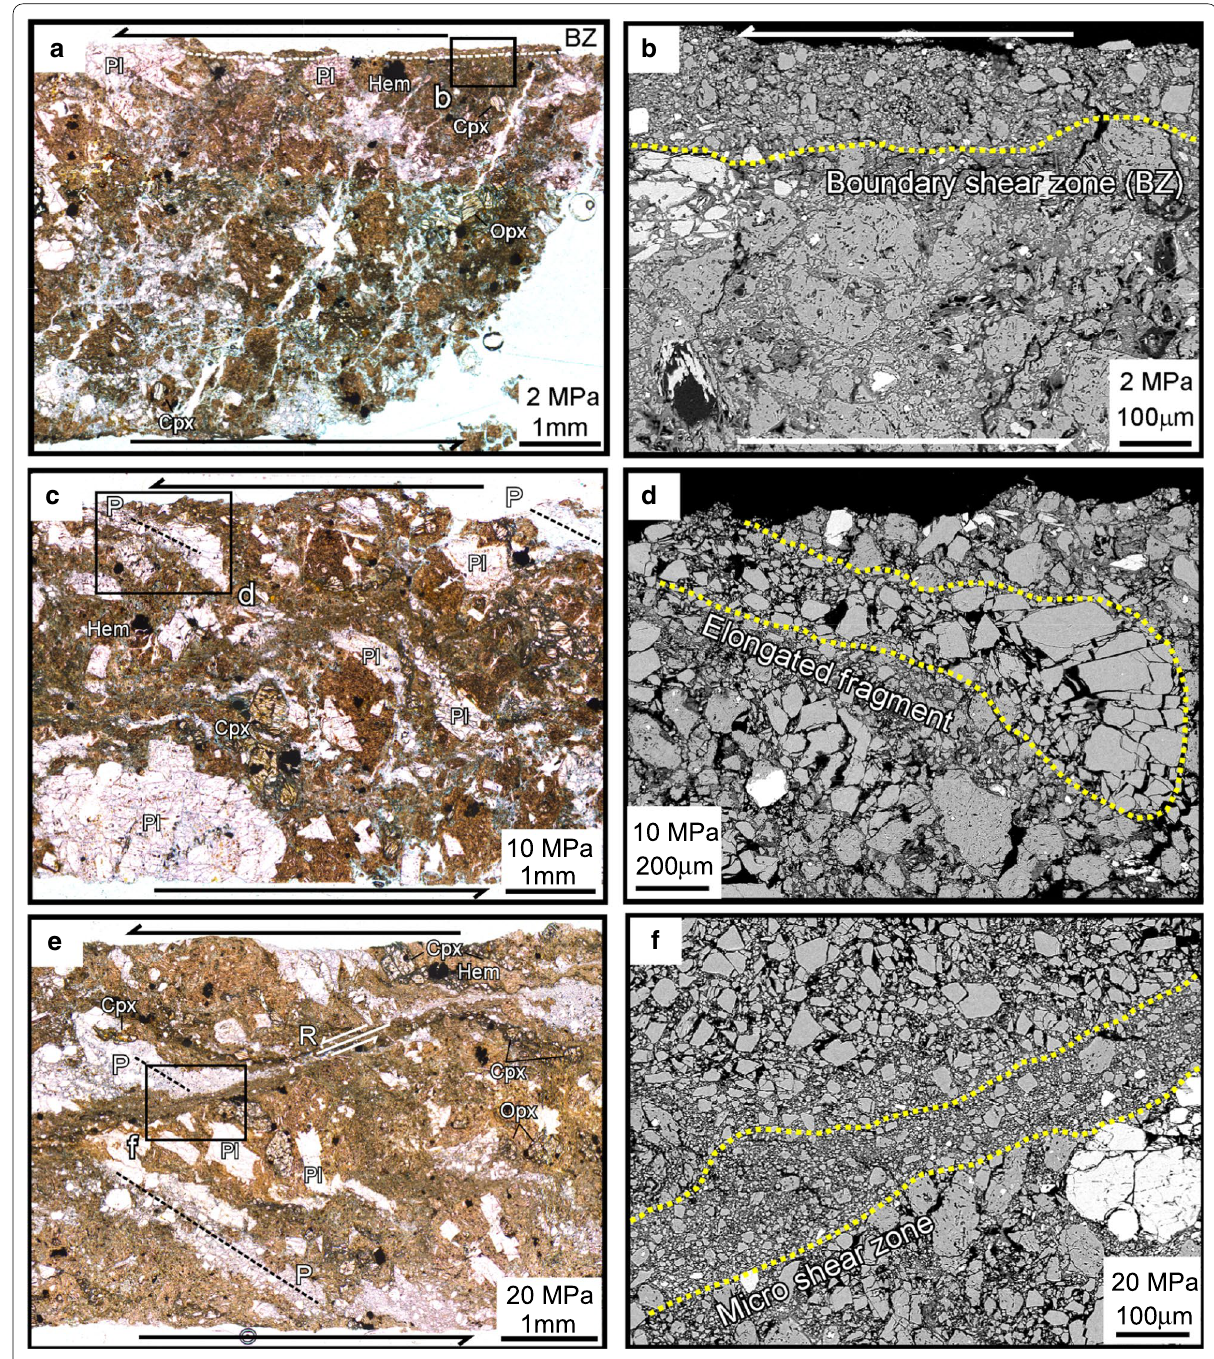
Fig. 6 Microstructures of the deformed samples after the velocity‑stepping friction tests at normal stresses of a , b 2 MPa, c , d 10 MPa and e , f 20 MPa, under optical ( a , c , f ) and electron ( b , d , f ) microscopes. Shear sense is top‑to‑the‑left. a The boundary shear zone (BZ), the lower boundary of which is delimited by the dotted white line, is located along the upper edge of the sample. The black box gives the position of b . b A close‑up view of the boundary shear zone characterized by < 20 μm small grains, located above the dotted yellow line. c The dotted lines indicate cataclastic P foliations formed in the upper part of the sample. The black box gives the position of d . d A close‑up view of elongated plagioclase fragments, demarcated by the dotted yellow line, forming the cataclastic foliation. e The P foliation (dotted lines) is pervasive across the bulk sample, and sometimes offset by left‑lateral Riedel shears (solid white line). The black box gives the position of f . f A close‑up view of the Riedel micro‑shear zone bounded by the dotted yellow lines. Pl, plagioclase; Opx, orthopyroxene; Cpx, clinopyroxene; Hem,